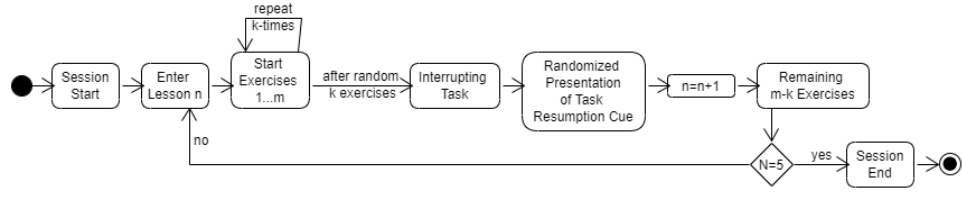
Figure 3. The process of our application as used for the lab evaluation. Interrupting tasks were triggered randomly and were always followed by a task resumption cue. The study ended after all five sessions were